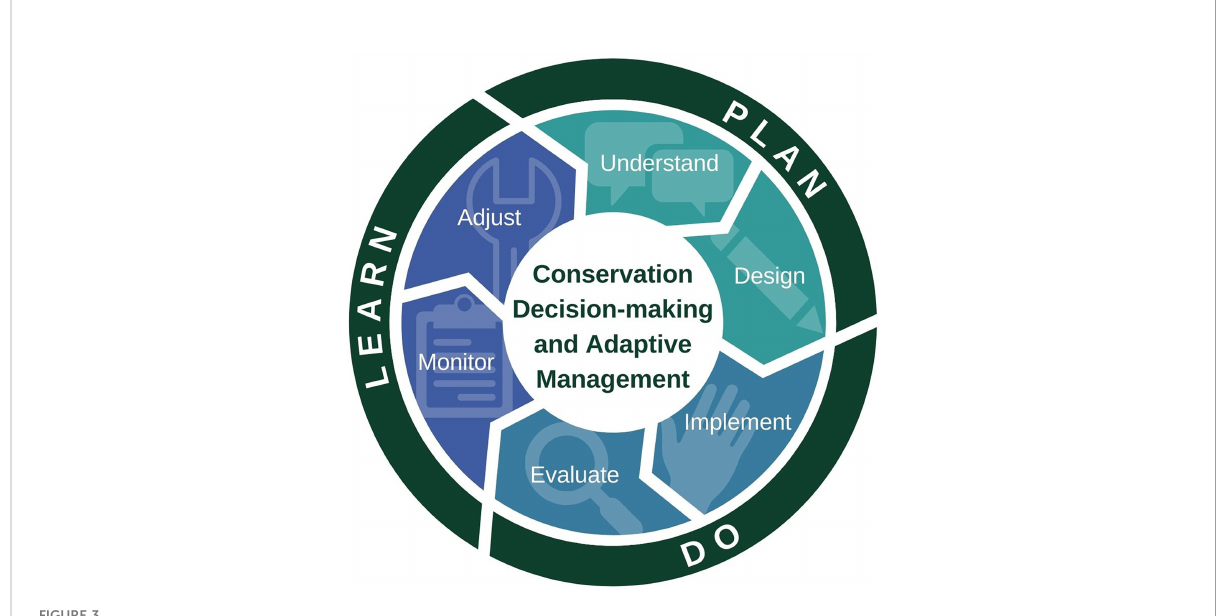
FIGURE 3 Integrating the elements of social science into the planning, doing, and learning phases of conservation decision-making and adaptive management (Credit: Sarah Wheedleton; Adapted from ESSA,